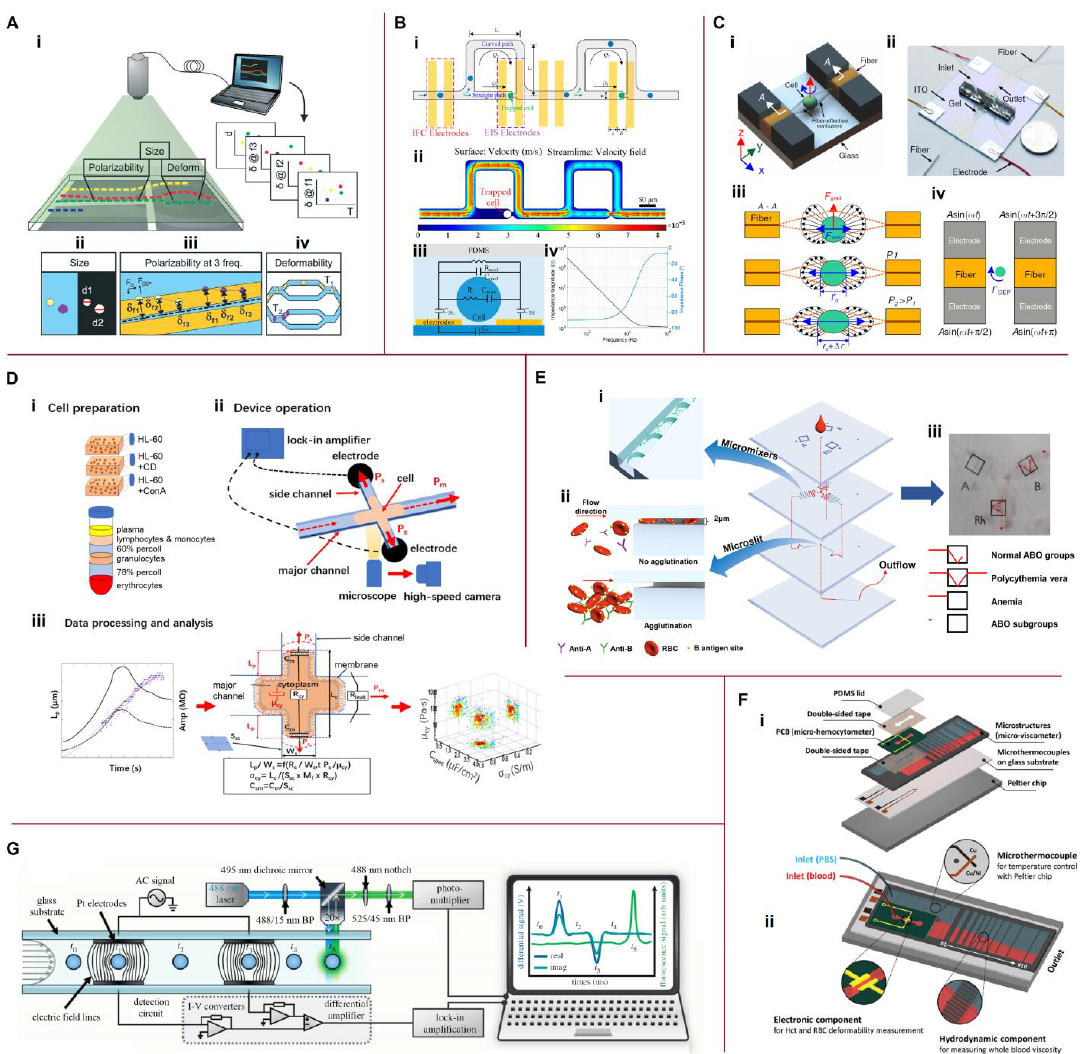
Figure 10. Multifunctional devices. ( A ) Multiparameter intrinsic cytometry: ( i ) Combining different microfluidic modules on one substrate. ( ii ) Size module. ( iii ) Multifrequency nDEP spring module. ( iv ) Deformability module. Reproduced with permission from [177]. Copyright 2018, The Royal Society of Chemistry. ( B ) Combination of impedance flow cytometry (IFC) and electric impedance spectroscopy (EIS): ( i ) Device design. ( ii ) Flow rate distribution in the channels. ( iii ) Electrical model of a single cell. ( iv ) Impedance magnitude and phase spectrum vs. frequency. Reproduced with permission from [178]. Copyright 2019, American Chemical Society. ( C ) Optical stretching and electrorotation of a single cell: ( i ) design and ( ii ) photograph of the chip. ( iii ) Working principle of optical stretch and ( iv ) electrorotation. Reproduced with permission from [179]. Copyright 2020, the author(s). ( D ) Characterization of single-cell cytoplasmic viscosity, cytoplasmic conductivity, and